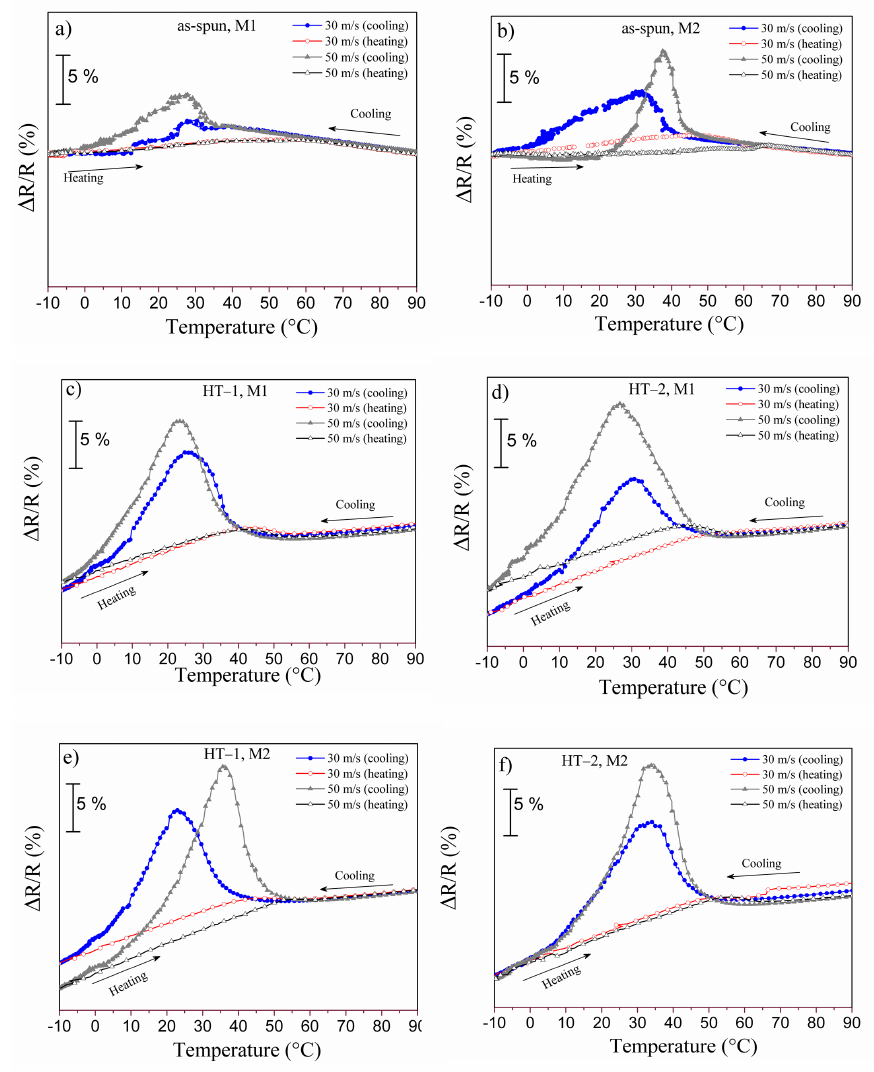
Figure 2. Dependence of the electrical resistance versus temperature curves corresponding to the (a-b) as-spun M1 and M2, (c-d) M1 with HT-1 and HT-2, (e-f) M2 with HT-1 and HT-2, respectively; in a complete thermal